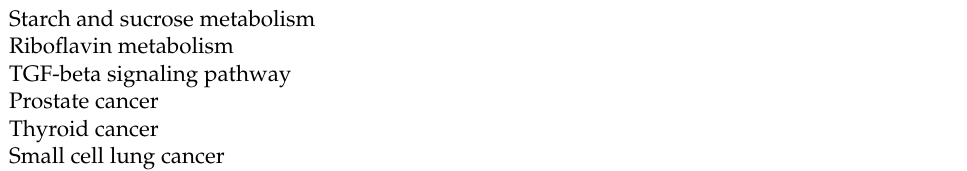
Table 3. The prognostic pathways shared by KIRC and